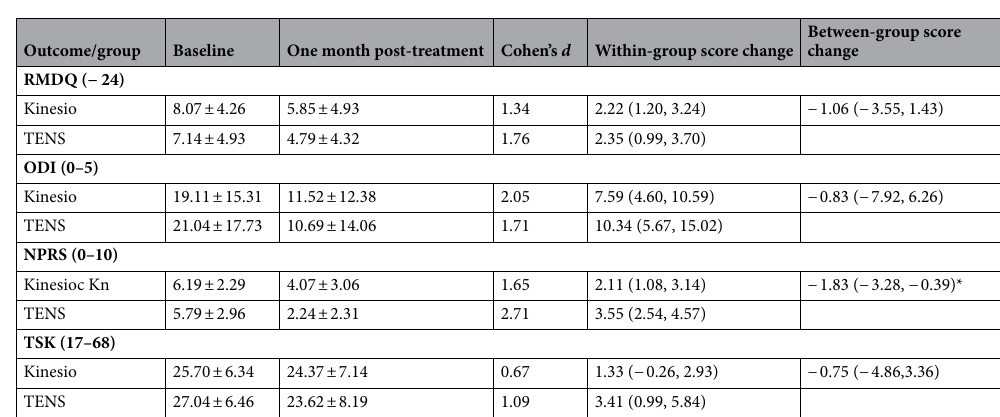
Table 2. Baseline, post-treatment, pre-post-treatment differences and change scores in each group (95% confidence interval) for self-reported outcomes: disability, kinesiophobia and pain. Values are expressed as means ± standard deviation for baseline and 1 month post-treatment and as mean (95% confidence interval) for within- and between-group change scores/*Significant Group * Time interaction (ANCOVA, p < 0.05). RMDQ the Roland Morris disability questionnaire), ODI Oswestry disability index, NPRS change from baseline numerical pain rating scale, TSK Tampa scale for kinesiophobia.